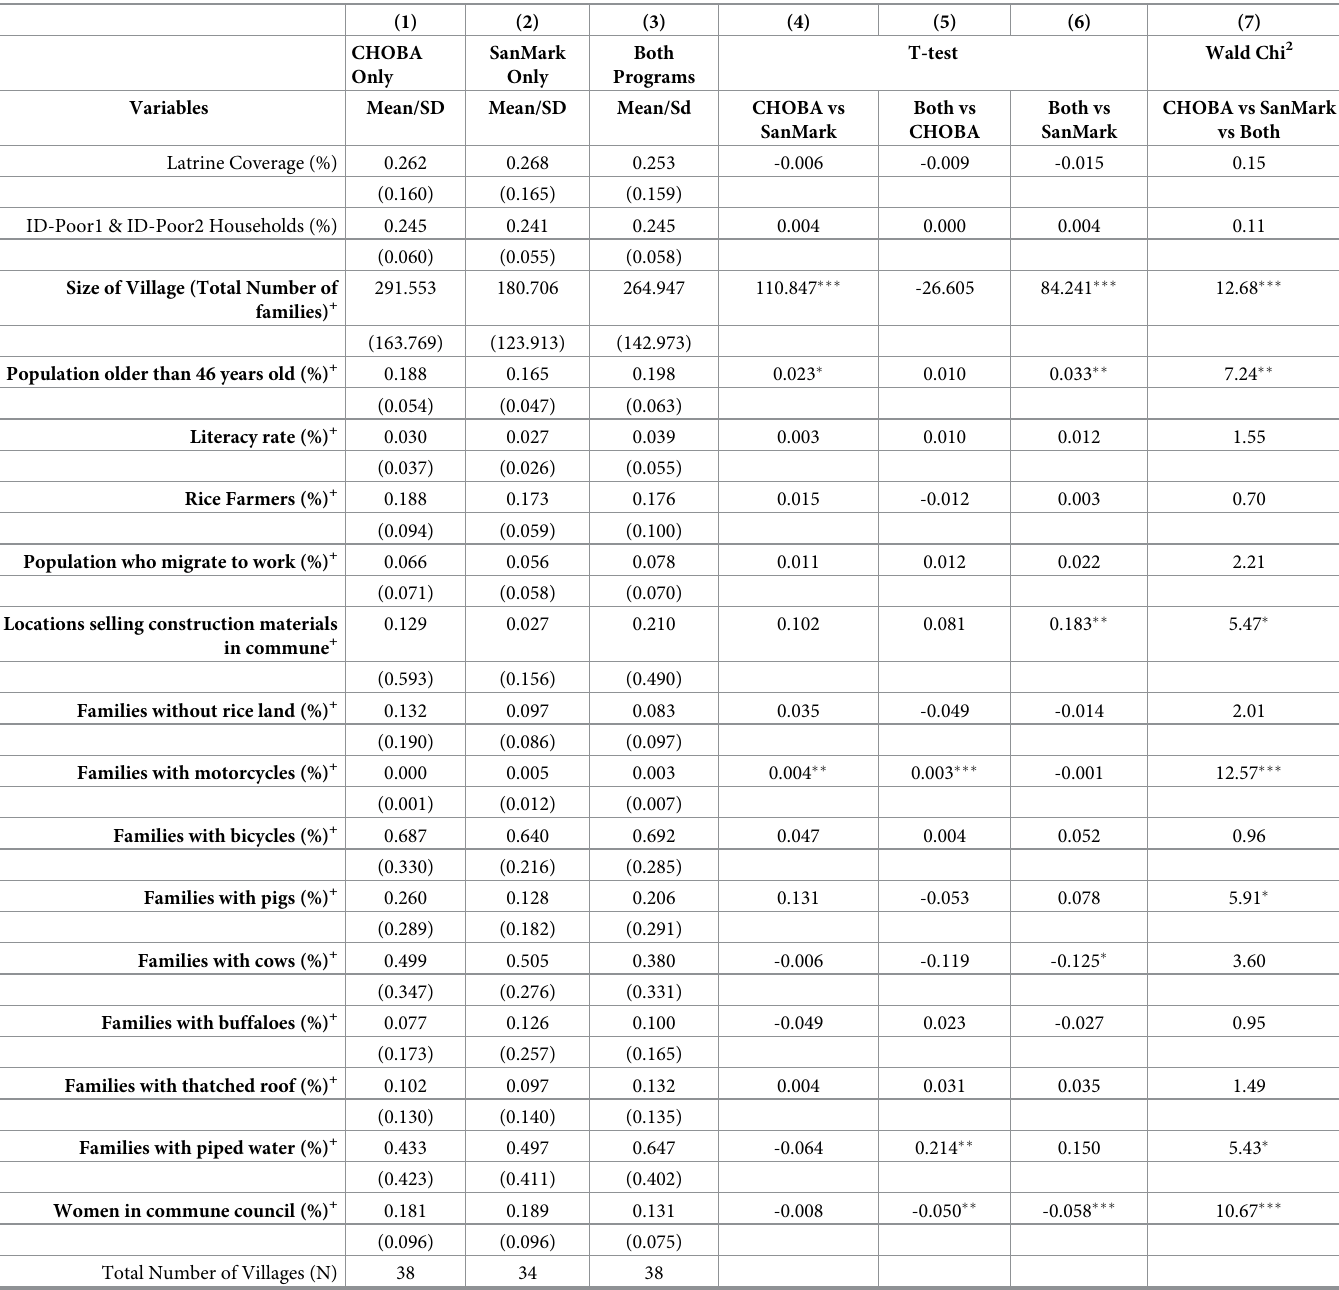
Table 2. Comparison of village level characteristics among matched villages at